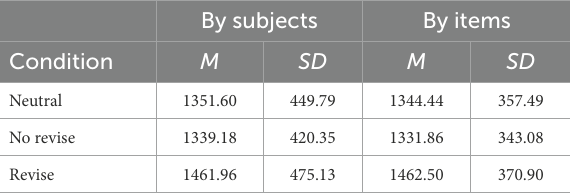
TABLE 2 Descriptive statistics of reading time for the critical sentence in Experiment 1. By subjects By